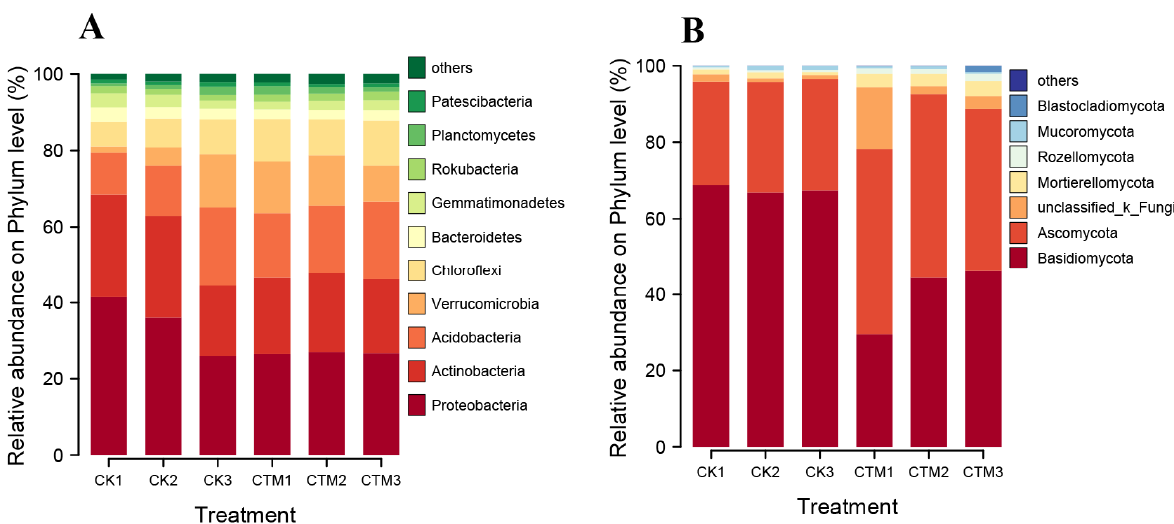
Figure 3. The relative abundance of soil bacterial ( A ) community and fungal ( B ) community in the phylum level of L. gmelinii plantation after crop tree management.